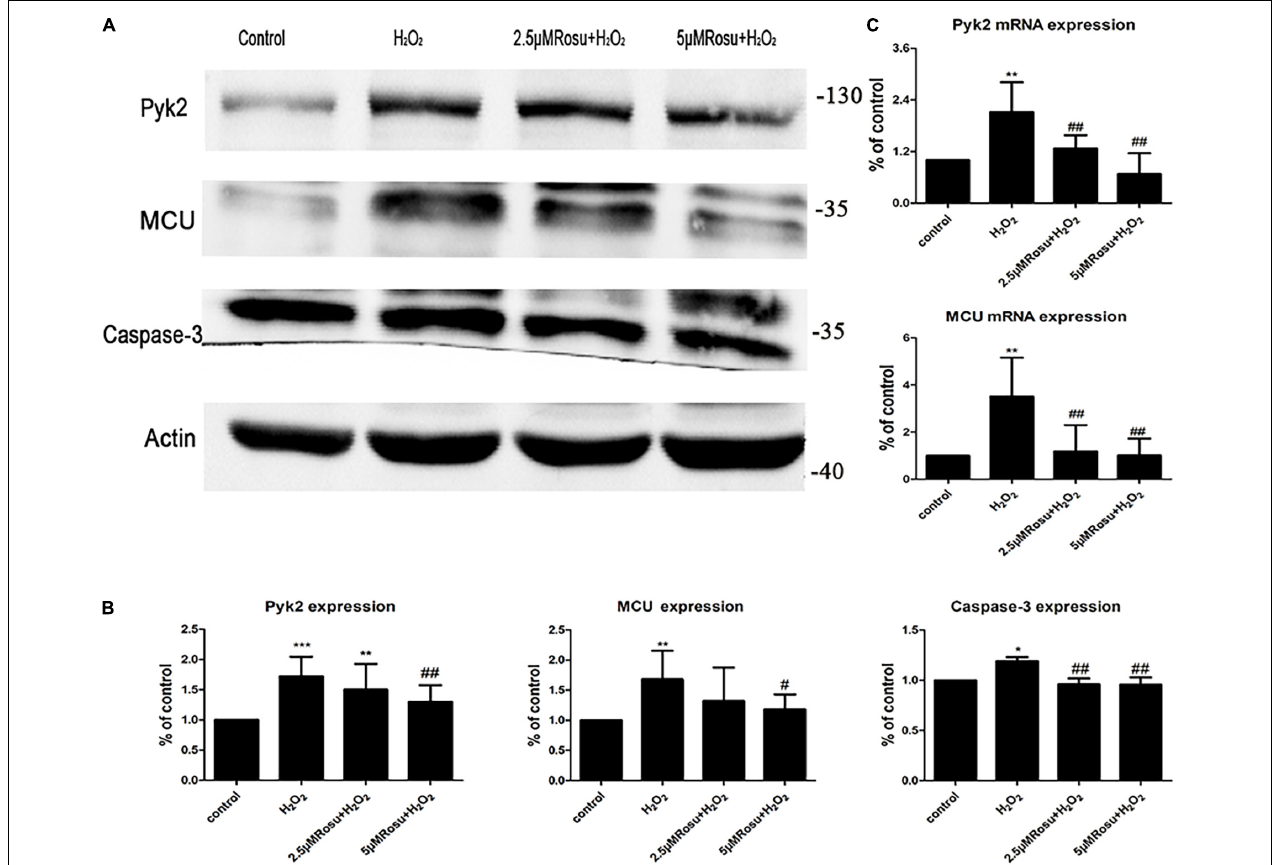
FIGURE 6 | The change of Pyk2/mitochondrial calcium uniporter (MCU) and caspase-3 protein expression in H 2 O 2 -induced human umbilical vein endothelial cells (HUVECs) injury. (A) Protein expression of Pyk2/MCU and caspase-3 in different groups. (B) Statistical graph of panel (A) . (C) The level of Pyk2 and MCU mRNA in H 2 O 2 -induced HUVEC injury. Data are shown as mean ± SD of at least three independent experiments. * P < 0.05, ** P < 0.01, *** P < 0.001 versus vehicle control; # P < 0.05, ## P < 0.01 versus vehicle H 2 O 2 group, one-way